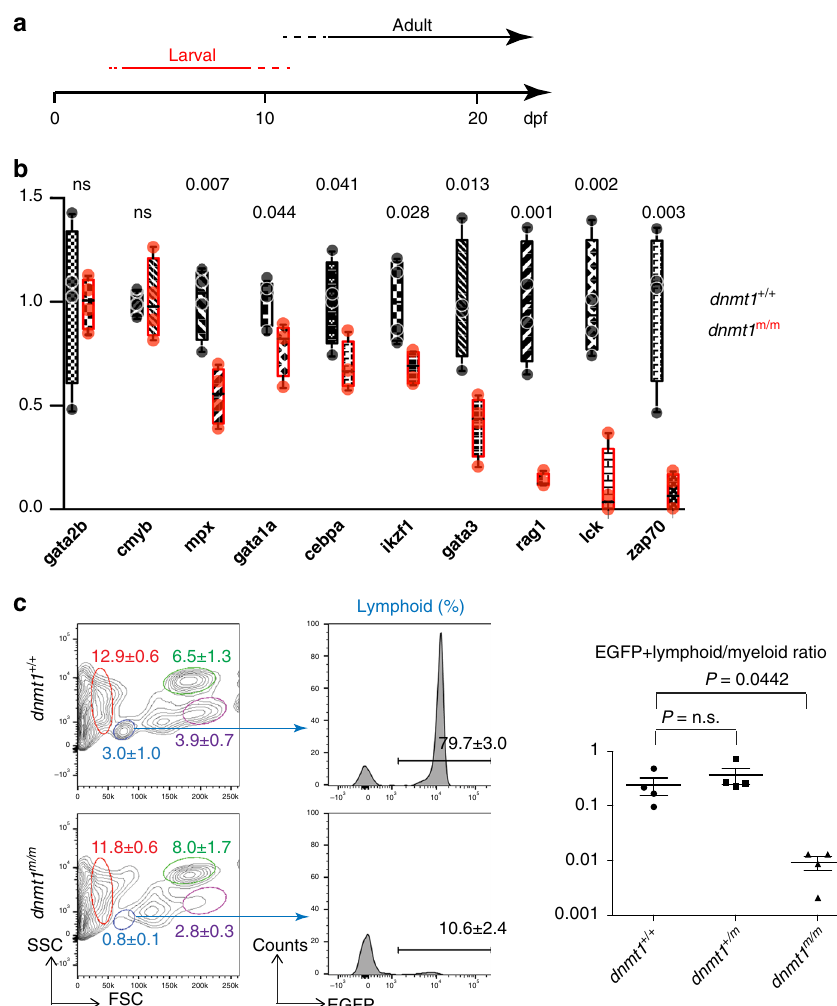
Fig. 2 Hematopoietic abnormalities in dnmt1 mutant fi sh. a Schematic indicating the two waves of T cell development in zebra fi sh, operationally referred to as larval and adult phases; the larval phase depends on the activity of the ikzf1 transcripton factor 28,46 . In the forward genetic screen, fi sh were analyzed at 5 dpf. b Expression patterns of selected genes associated with hematopoietic development in 5 dpf G2 embryos. Levels were determined by qPCR and normalized to the levels of actb1 ( n = 4; mean; whiskers represent maximum and minimum values; individual data points are indicated). c Adult lymphopoiesis fails in mutant fi sh. Flow cytometric analyses of whole kidney marrow (WKM) cells 47 of wild-type and dnmt1 mutants, both transgenic for an ikzf1-EGFP reporter 27,28 (left panels). Circles denote different blood cell populations in adult wild-type fi sh: red, erythrocytes; blue, lymphocytes; magenta, precursors; green, myelomonocytes. Percentages (mean ± SD) of each population in WKM preparations are indicated ( n = 4, for both genotypes; left panels). Analysis of EGFP-positive cells in the lymphocyte gates; percentages of positive cells are indicated in the histograms ( n = 4, for both genotypes; middle panel), and enumerated (right panels). FSC, forward light scatter; SSC, side light scatter. Source data are provided as Source Data fi